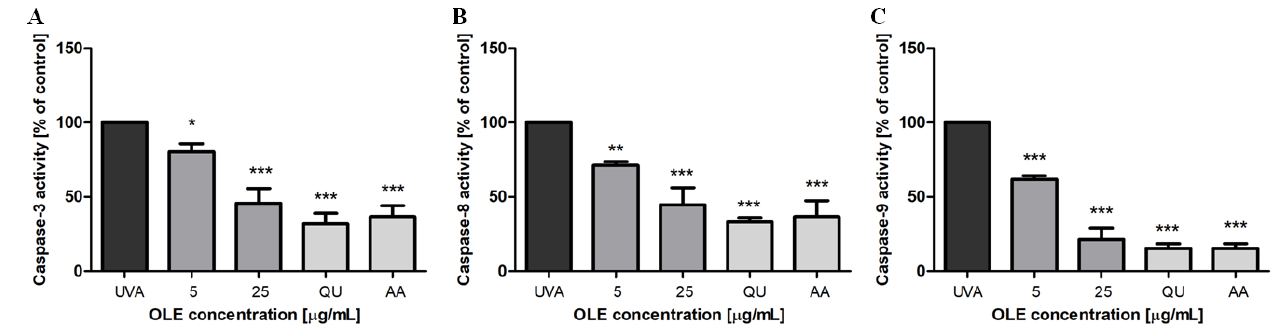
Figure 3. Inhibitory effect of OLE on UVA-induced activation of caspase-3 ( A ), -8 ( B ) and -9 ( C ) in human skin fibroblasts. Caspase activities are expressed as % of control, where the caspase activity in untreated and UVA-irradiated cells were taken as 100%. The figure shows mean results from 3 independent experiments. Error bars denote ± SD. * p < 0.05, ** p < 0.01, *** p < 0.001 compared to cells irradiated in the absence of OLE or the reference antioxidants (UVA).